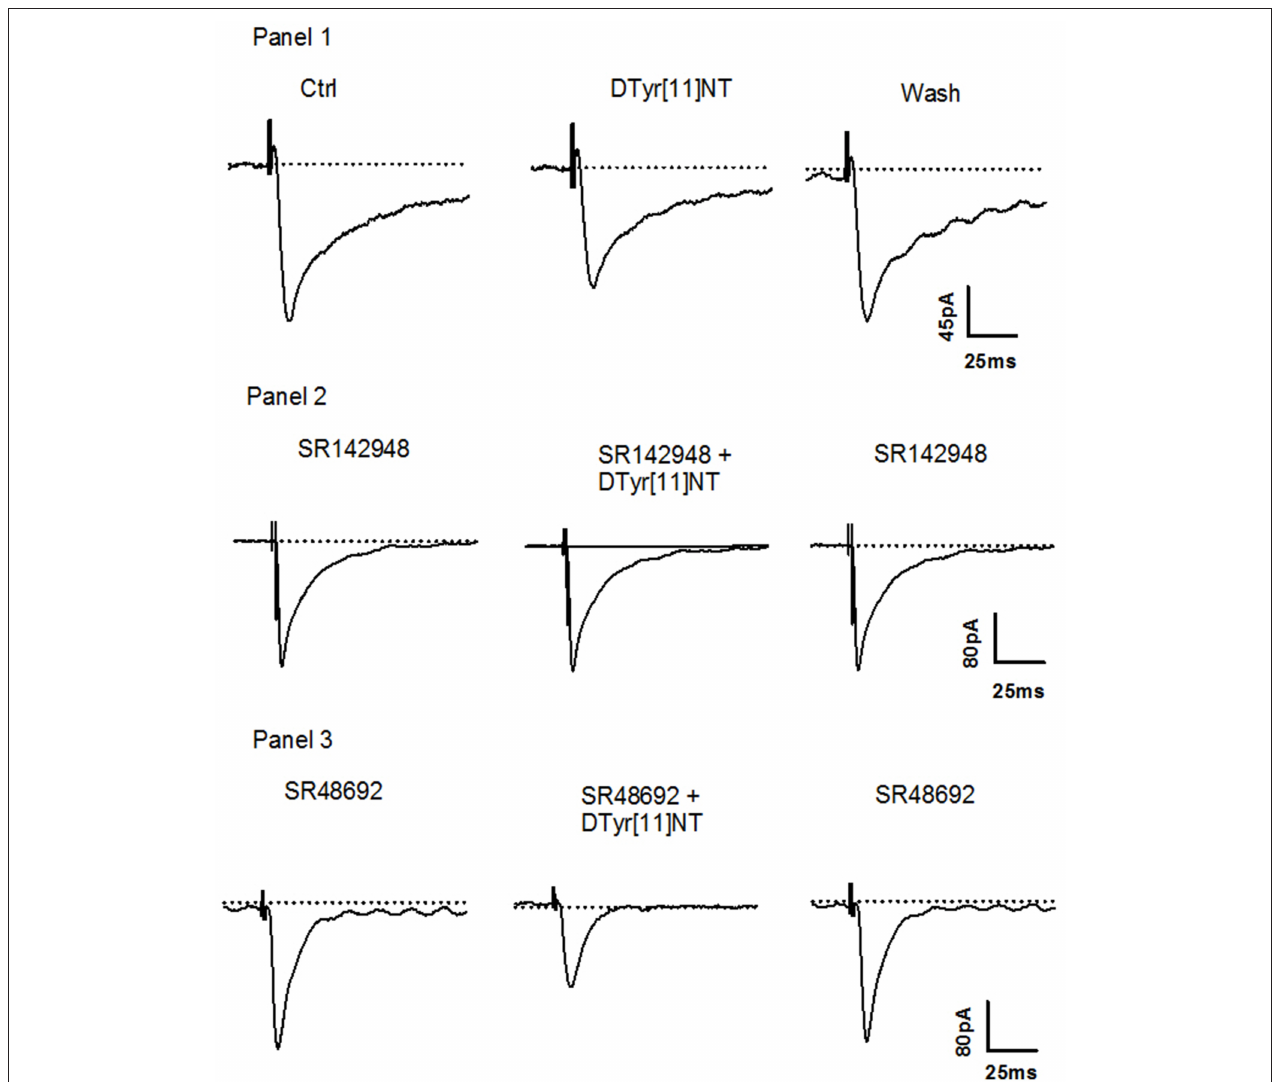
FIGURE 4 | Effect of [D-Tyr 11 ]NT and antagonists on I + h neurons. Panel 1: Current traces of glutamatergic EPSC recorded during superfusion of [D-Tyr 11 ]NT ; control (1), with [D-Tyr 11 ]NT (0.01 µ M) (2) and following the washout of [D-Tyr 11 ]NT (3) at a holding membrane potential of − 70mV in I + h neurons ( n = 6 ). Panel 2: Current traces of glutamatergic EPSC recorded during superfusion with SR142948 (0.1 µ M) (1), with SR142948 and [D-Tyr 11 ]NT (0.01 µ M) (2) and with SR142948 following the washout of (3) at a holding membrane potential of − 70mV in I + h neurons ( n = 5 ). Panel 3: Current traces of glutamatergic EPSC recorded during superfusion with SR48692 (0.1 µ M) (1), with SR48692 and [D-Tyr 11 ]NT (0.01 µ M) (2) and with SR48692 following the washout of [D-Tyr 11 ]NT (3) at a holding membrane potential of − 70mV in I + h neurons ( n = 4